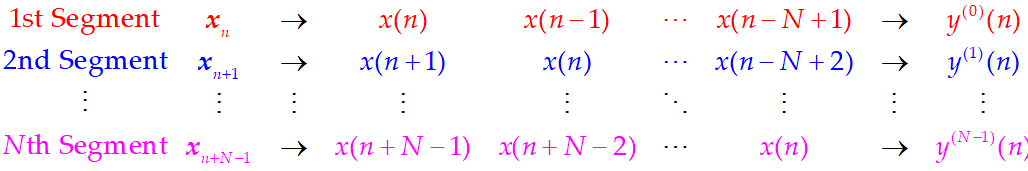
Figure 1. Demonstration of APDF (all outputs according to inputs x ( n ) ).